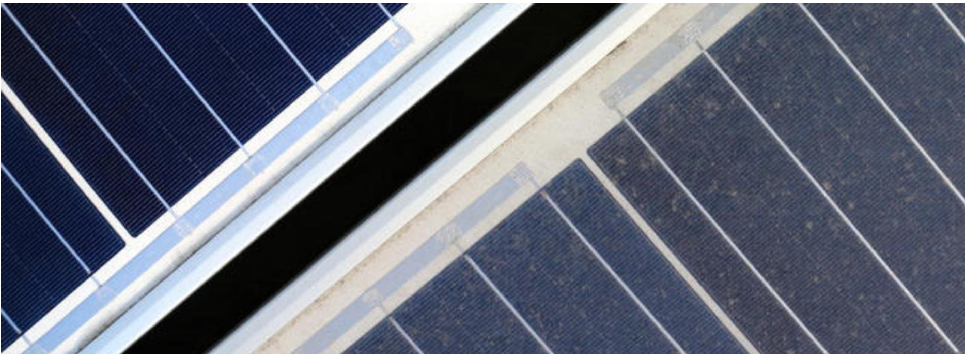
Figure 3. The classification of a PV panel—one of two